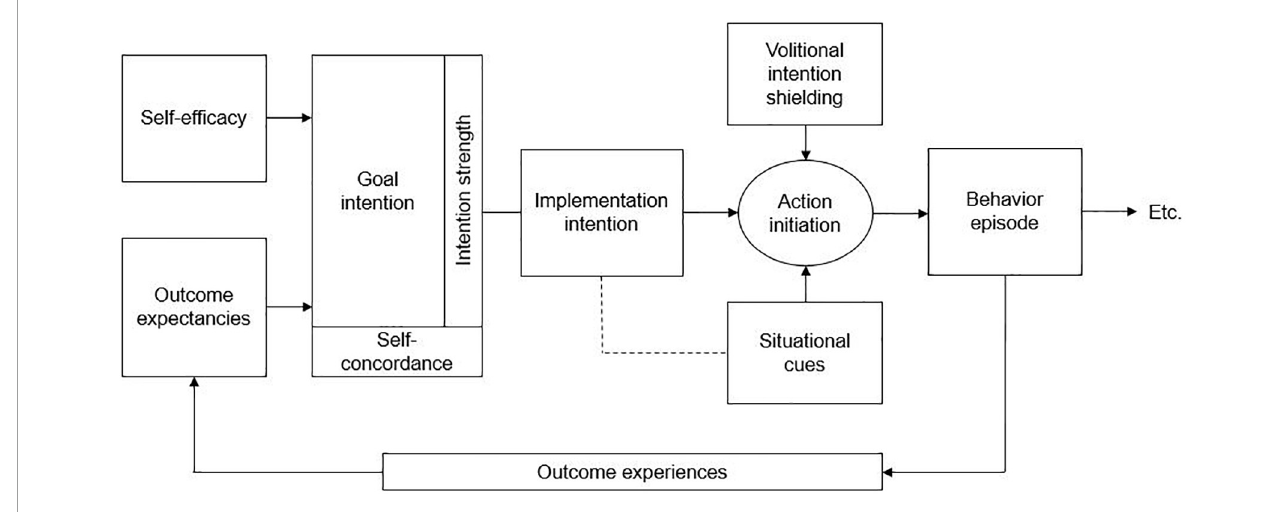
FIGURE1 Motivation volition (MoVo) model according to Fuchs et al.